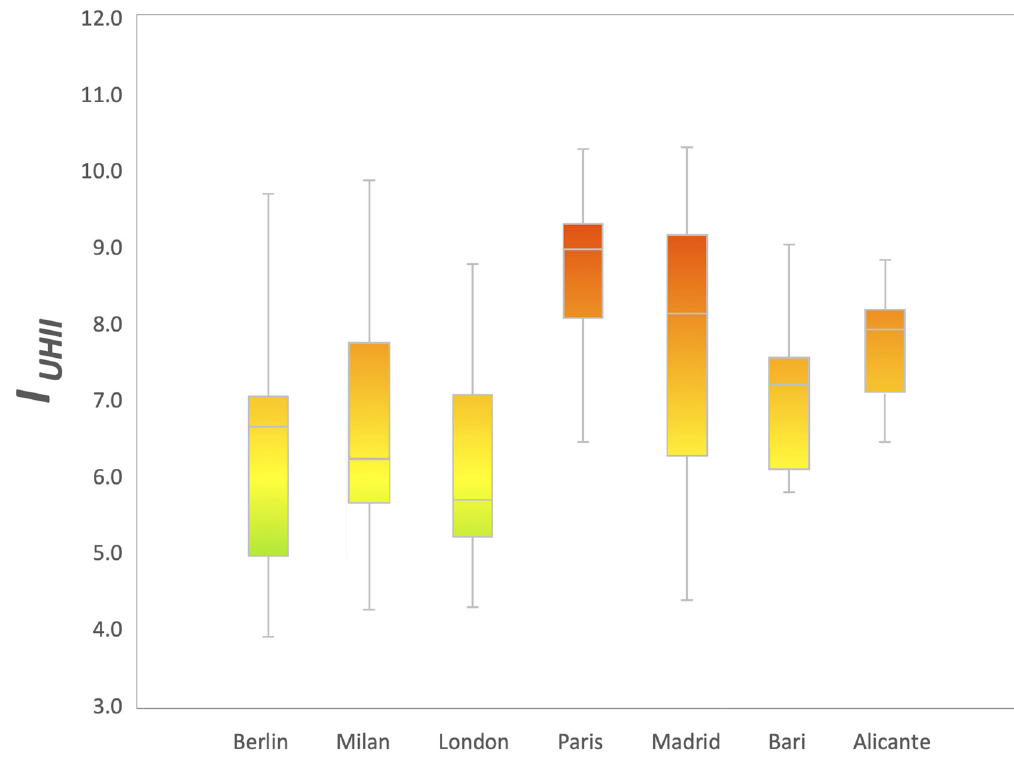
Figure 6. Boxplot chart representing the boxplot of the statistical distribution of the UHI evaluated in the investigated districts and cities.